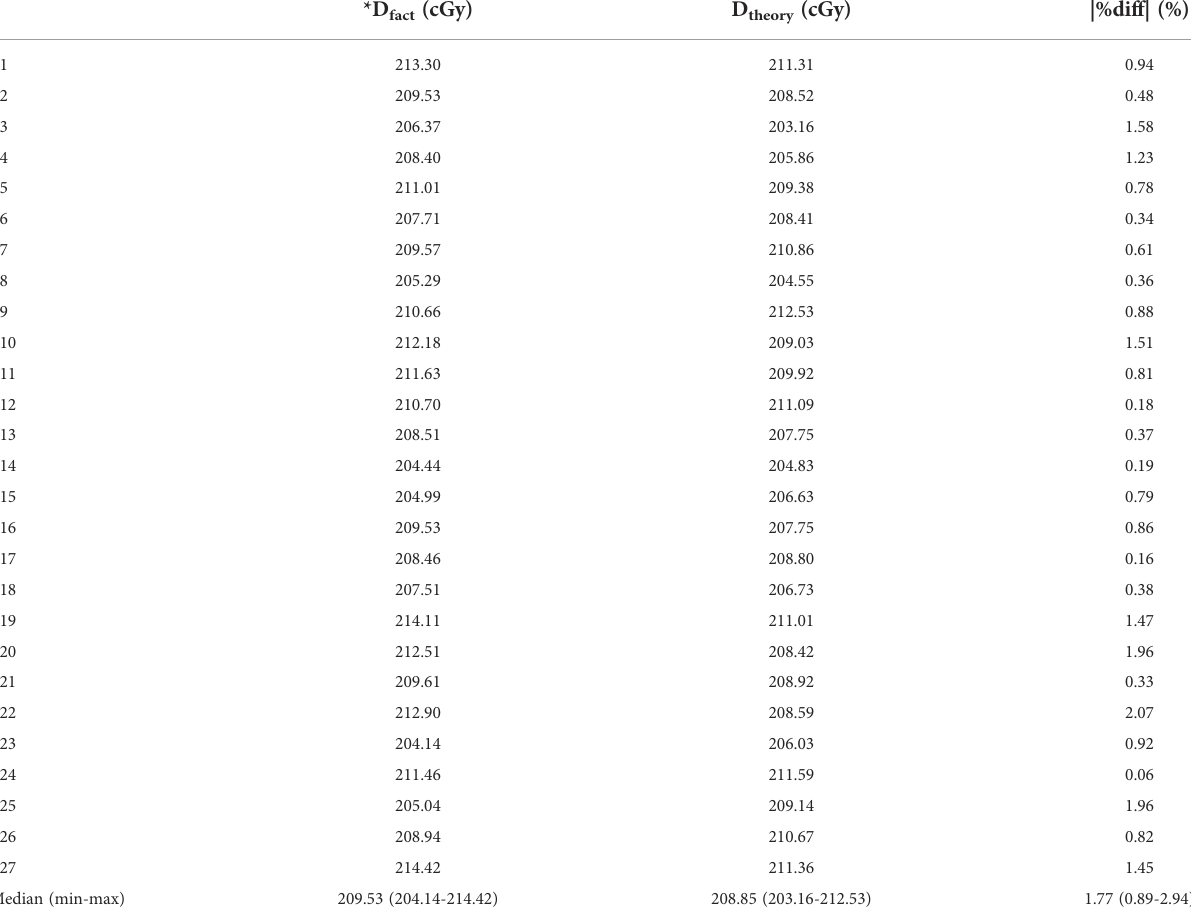
TABLE 3 Dose accuracy veri fi cation on skin surface of the 27